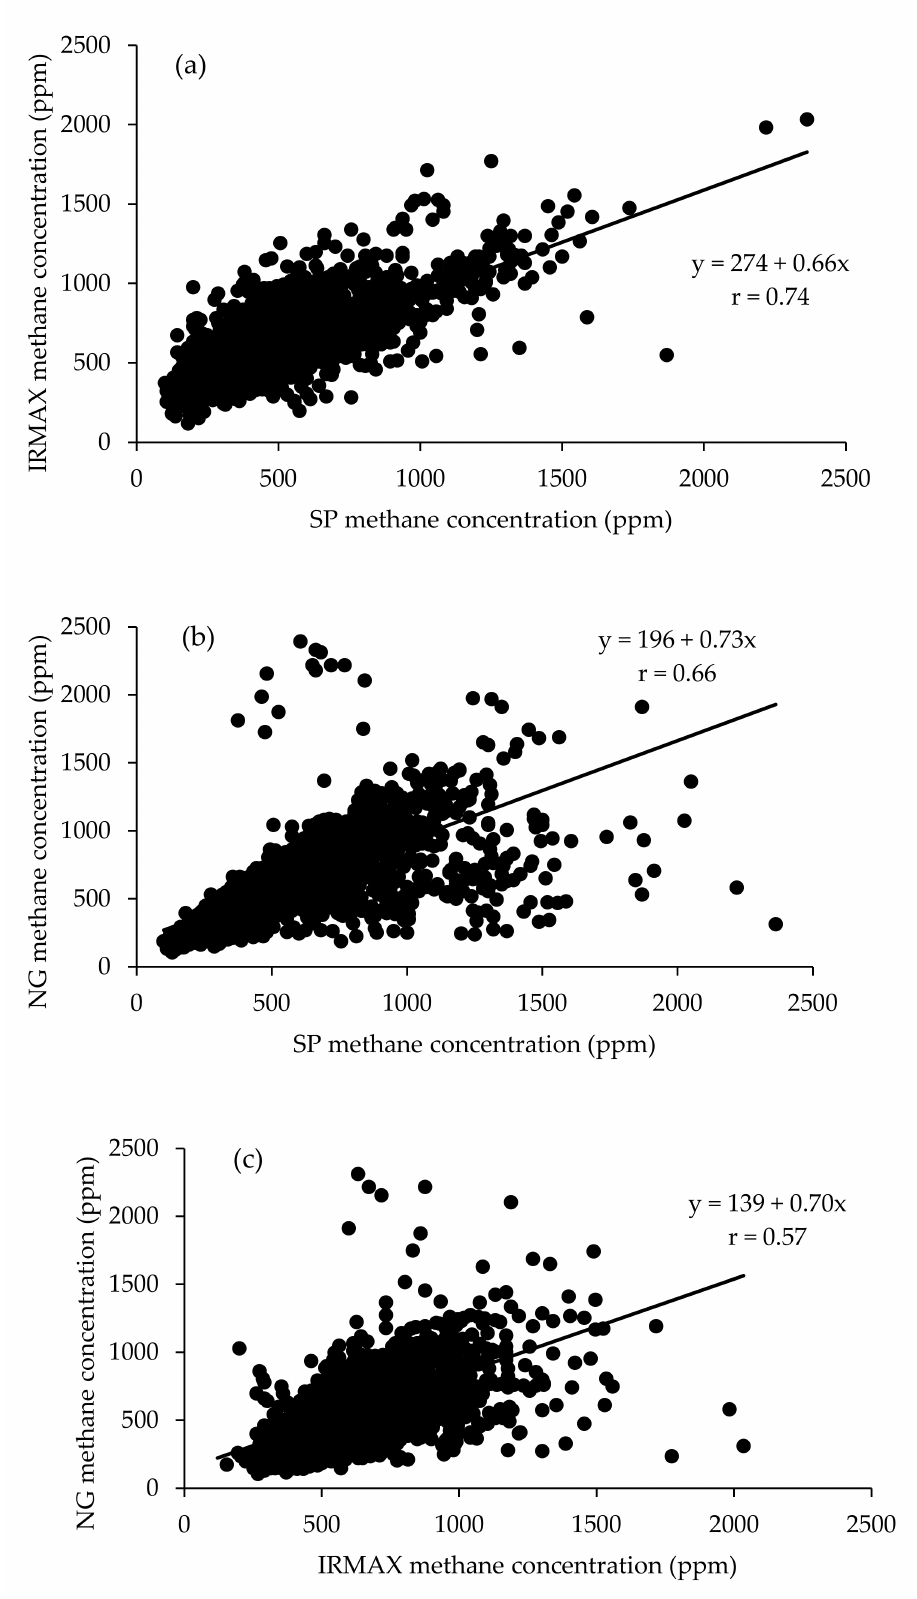
Figure 2. The relationship between maximum eructation peaks measured by ( a ) IRMAX and SP gas analysers, ( b ) Guardian NG and SP gas analysers, and ( c ) IRMAX and NG gas analysers during the study